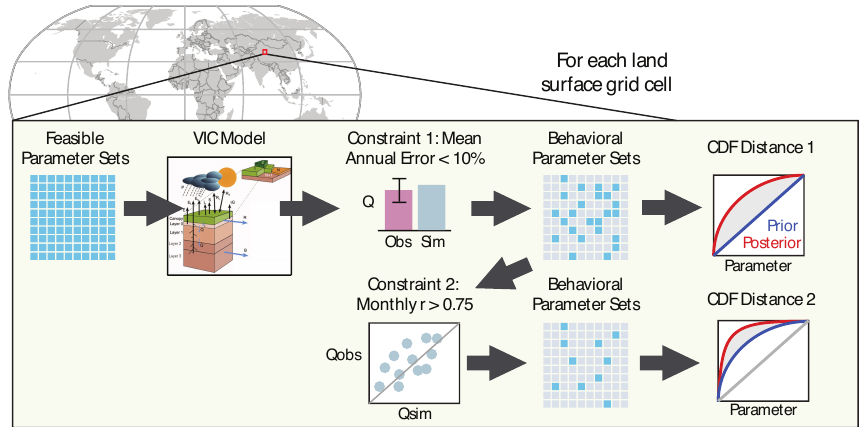
Figure 1. Steps used to build and constrain the 10000 Latin hypercube VIC ensemble. The CDF distance is calculated for each VIC parameter after applying the annual error constraint and again after applying the monthly correlation